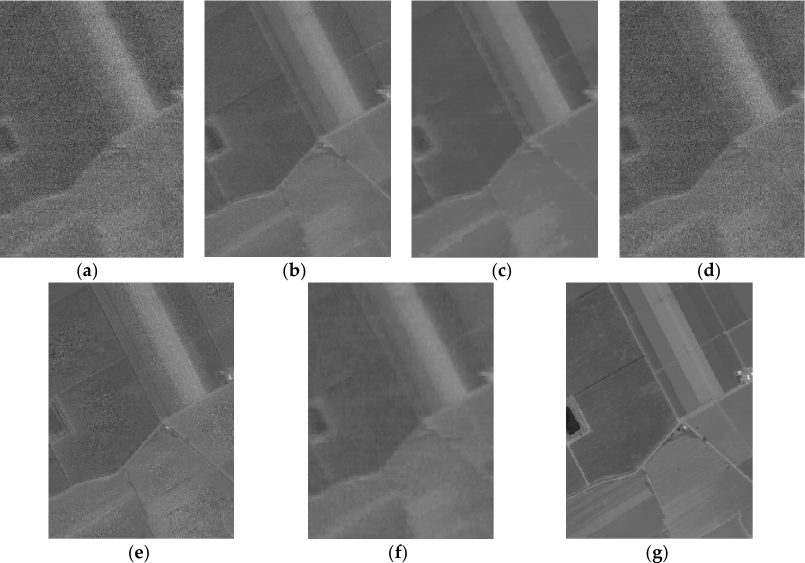
Figure 10. Denoised results by different methods of the second band in the Salinas dataset: ( a ) original, ( b ) HyRes, ( c ) LRTV, ( d ) LRMR, ( e ) NAILRMA, ( f ) LRTDTV, and ( g ) proposed.